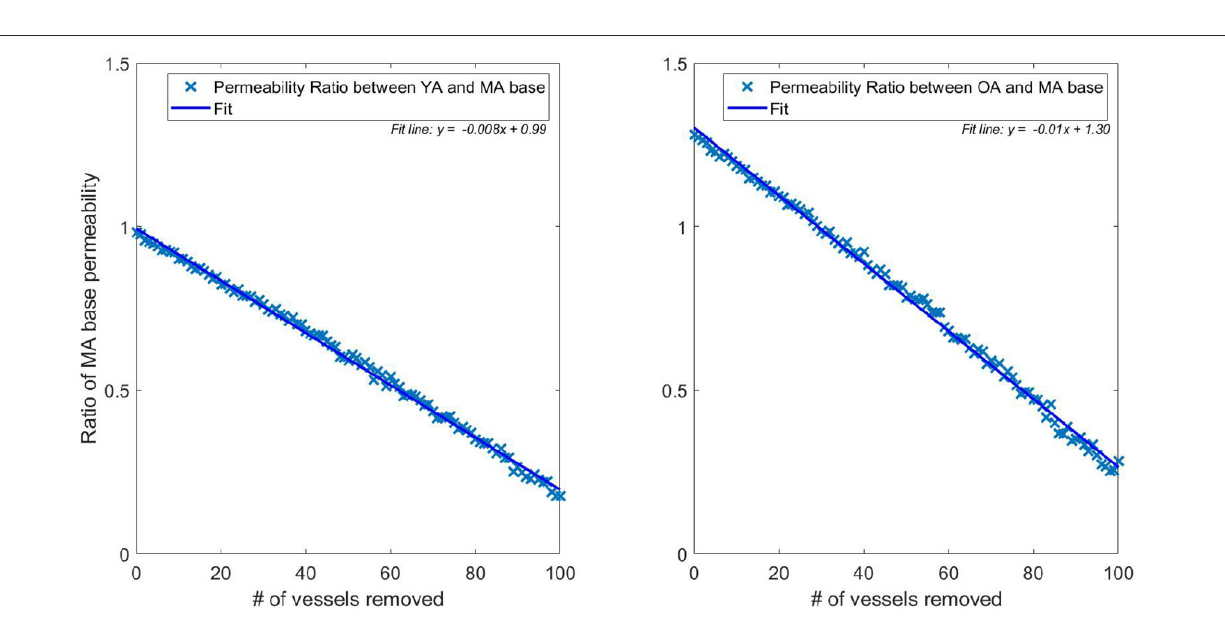
FIGURE 5 | Ratio of pruned network permeability to the unpruned MA base permeability (data points represent the average permeability over 166 networks for each specific number of pruned vessels). Note that the YA, MA, and OA brains all start with the same vessel density—only radius and viscosity is modified for the different age groups. This elucidates the impact of removing individual vessels on permeability in young (left) and old (right)